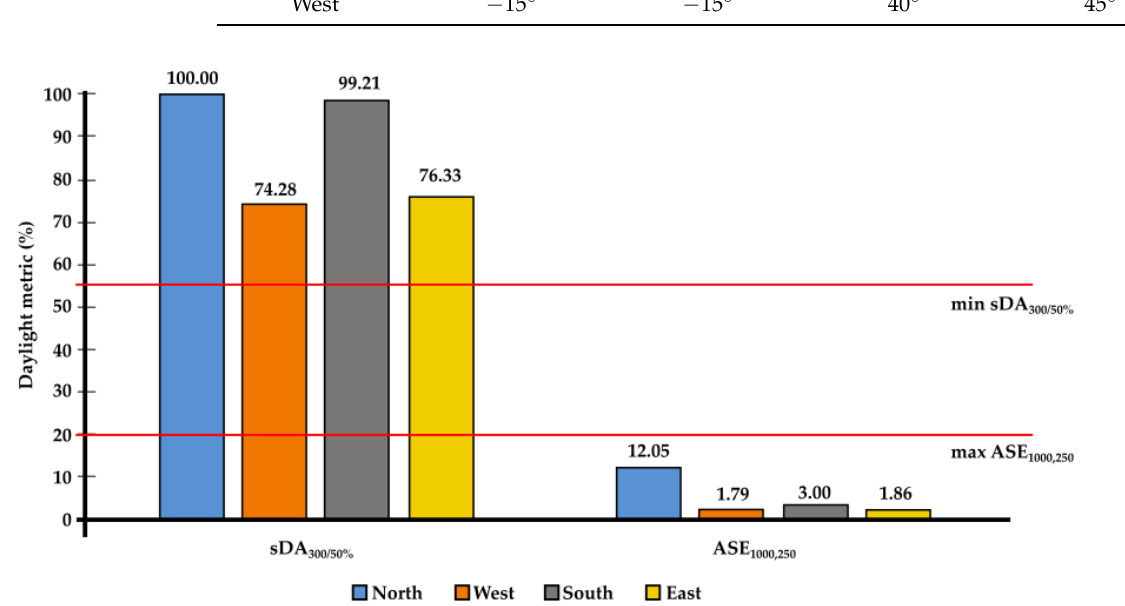
Figure 15. Annual simulation results in the adaptive shading design option.